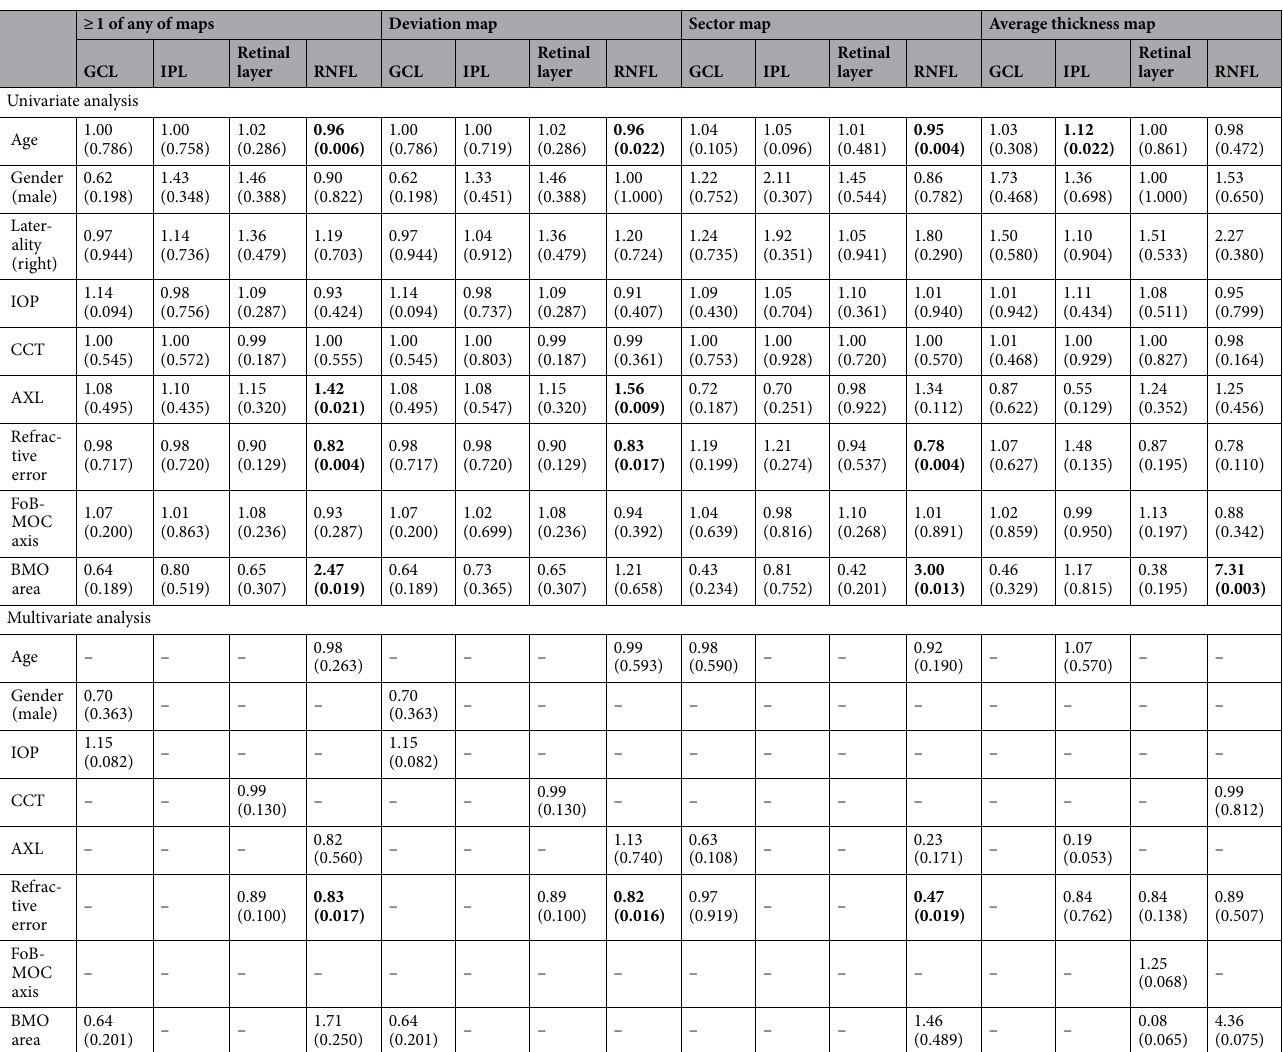
Table 2. Factors associated with false-positive classification on segmented macular layers and retinal nerve fiber layer analysis maps in univariate and multivariate logistic regression analyses. AXL axial length, BMO Bruch’s membrane opening, CCT central corneal thickness, FoBMOC Fovea-to-BMO-Center, GCL ganglion cell layer, IOP intraocular pressure, IPL inner plexiform layer, RNFL retinal nerve fiber layer. Data are odds ratio with p value in parenthesis. Significant values are in